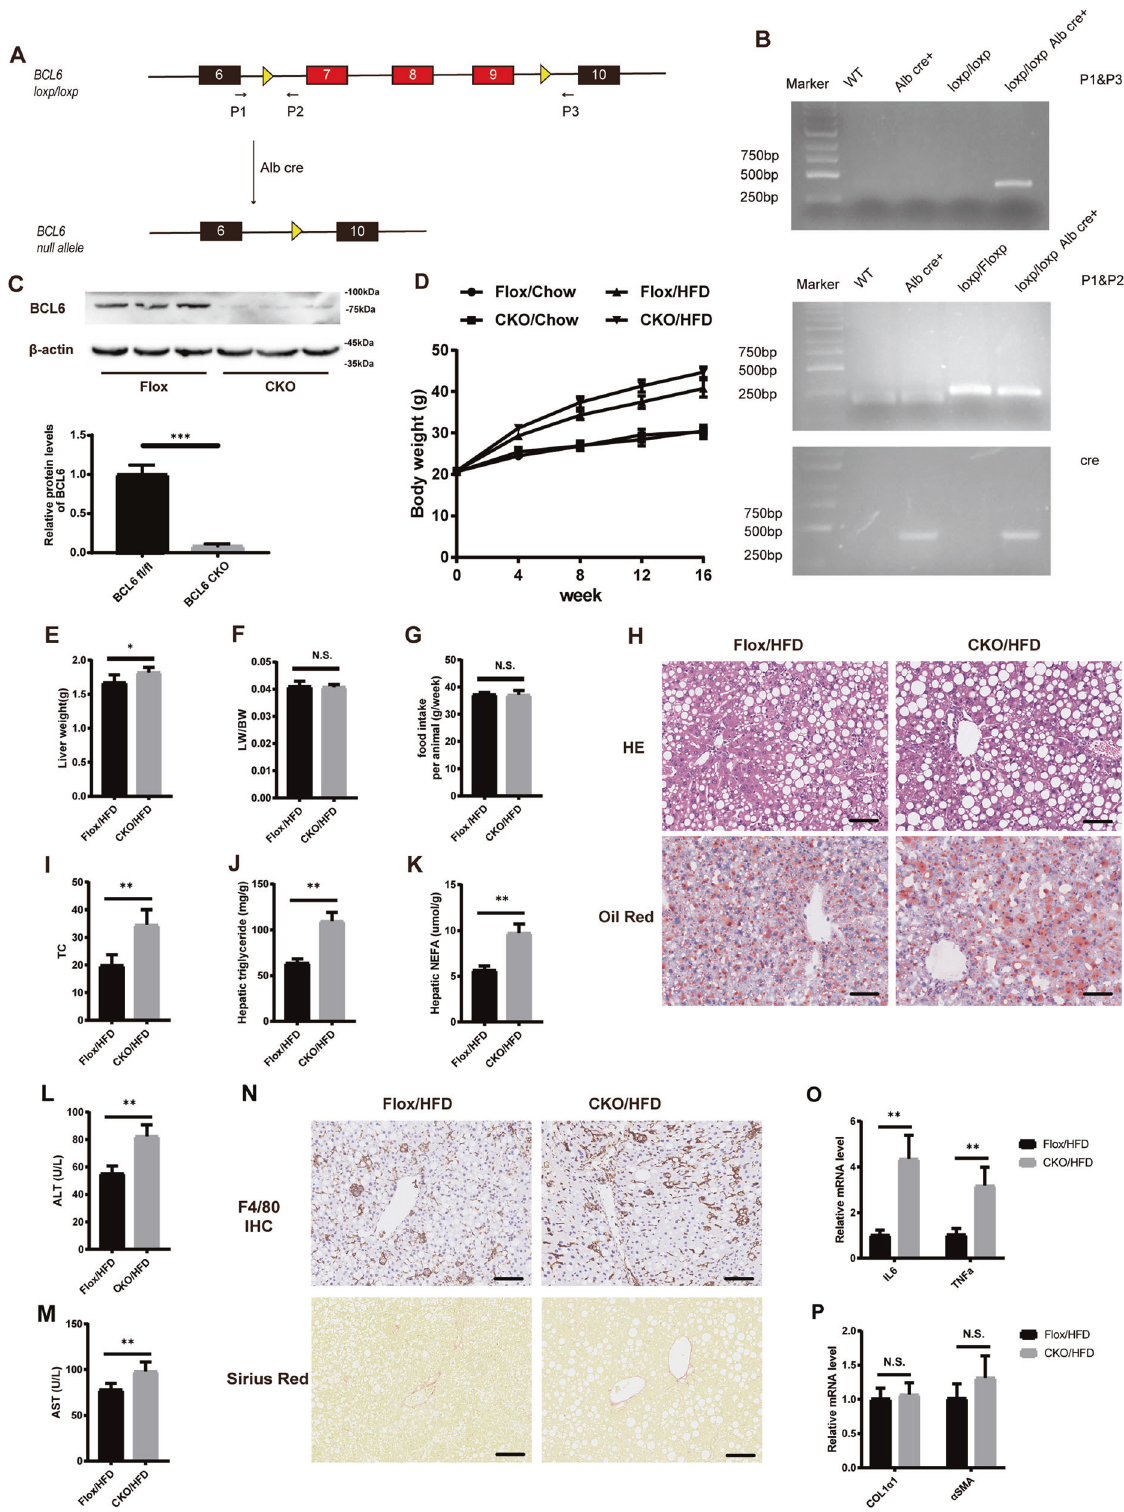
Fig. 3 BCL6 knockout aggravates HFD-induced hepatic steatosis. A Schematic image of the generation of a liver-speci fi c BCL6-CKO mouse (BCL6-CKO) strain. B Mouse genotyping was con fi rmed by PCR. C Protein expression of BCL6 in the liver of fl ox and CKO mice. D Bodyweight, ( E ) liver weight, ( F ) LW/BW, and ( G ) food intake of the BCL6-CKO and BCL6- fl ox mice at 16 weeks post-HFD administration ( n = 6/group). H Representative images of H&E (upper) and oil red O (bottom) staining of liver tissues from the BCL6-CKO and BCL6- fl ox mice fed an HFD for 16 weeks. Scale bar, 100 μ m. I Total cholesterol, J triglyceride, K NEFA, and L ALT and M AST levels in the livers from the BCL6-CKO and BCL6- fl ox mice fed an HFD for 16 weeks. ( n = 6/group). N Representative images of immunohistochemistry staining of F4/80 and Sirian red staining of liver tissues from two group mice. Scale bar, 100 μ m. Hepatic mRNA levels of ( O ) IL-6 and TNF α , ( P ) COL1 α 1and α SMA from two group mice fed an HFD for 16 weeks ( n = 6/ group). Data represent the mean ±SEM, * P <0.05, ** P <0.01, *** P <0.001 and N.S. indicates no signi fi cance between the two indicated groups. Cell Death and Disease (2022)